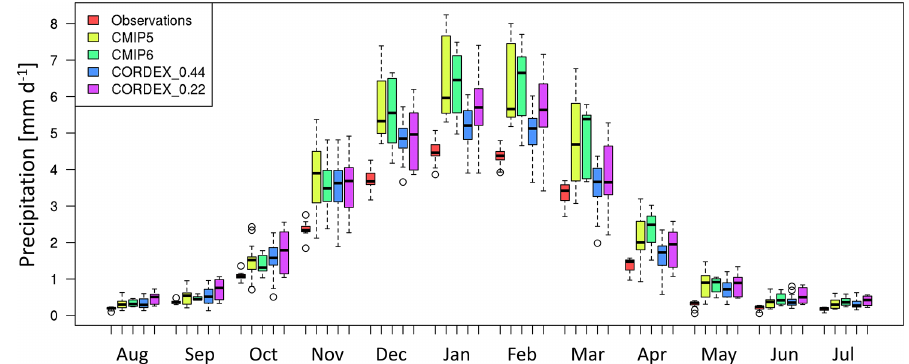
Figure 3. Annual cycle of monthly precipitation during 1986–2005 for the ensemble of observational data (gauge-based, satellite and reanal- ysis), CMIP5 (Coupled Model Intercomparison Project Phase 5), CMIP6 (Coupled Model Intercomparison Project Phase 6), CORDEX0.44 (Coordinated Regional Climate Downscaling Experiment – Africa domain with a spatial resolution equal to 0.44 ◦ × 0.44 ◦ ) and CORDEX- 0.22 ◦ (CORDEX-Africa simulations with a spatial resolution equal to 0.22 ◦ × 0.22 ◦ ). The thick horizontal black lines indicate the ensemble median for each month, the box encloses the interquartile range and the tails denote the full ensemble range. Circles represent the outliers for each ensemble. Only grid points are considered.